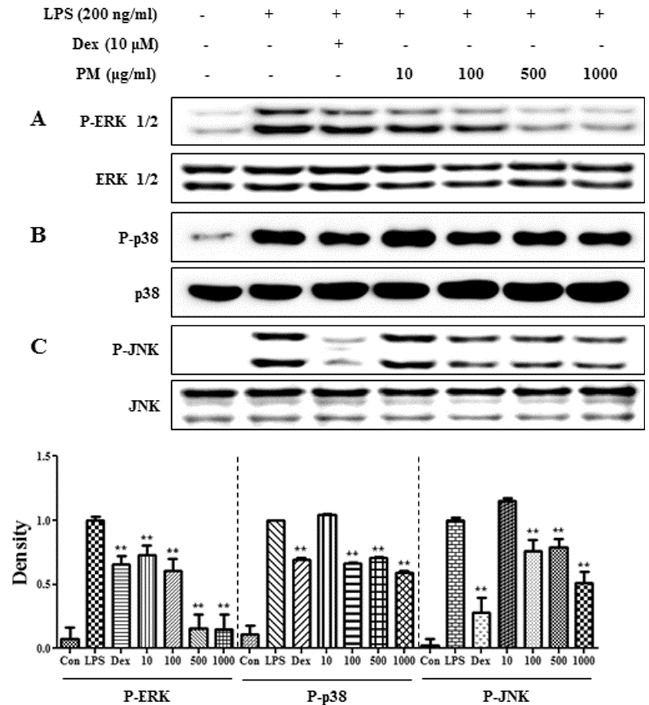
Figure 4. Inhibitory effect of PM on the phosphorylation of ( A ) ERK ; ( B ) p38 and ( C ) JNK MAPK in macrophages. RAW 264.7 cells were treated with PM for 30 min and then incubated with LPS for 30 min. Cell lysates were analyzed by Western